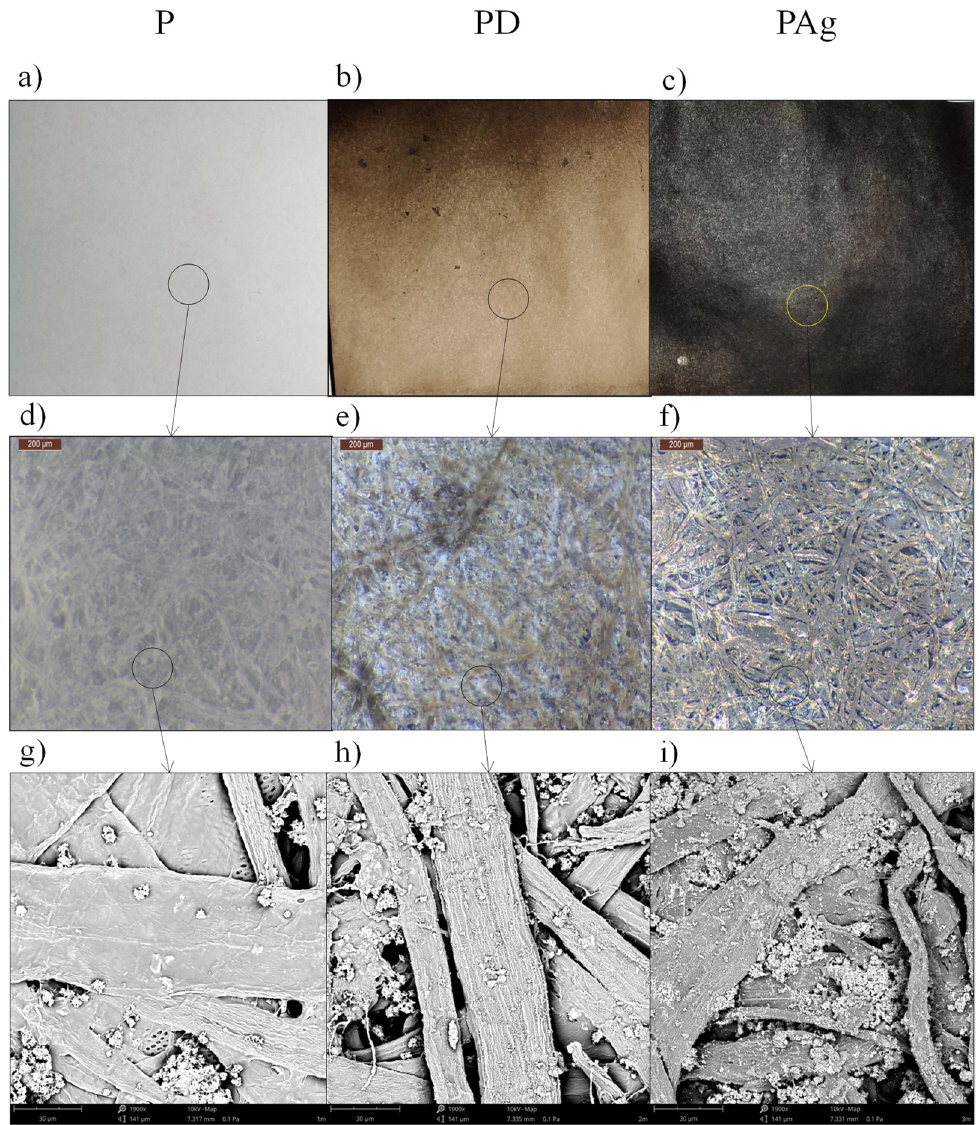
Figure 2. Macroscopic photos (first row), optical macroscopy (second row) and scanning electron microscopy (third row) of ( a , d , g ) blank paper (P), ( b , e , f ) paper with polydopamine coating (PD) and ( c , f , i ) paper after surface activation (PAg).